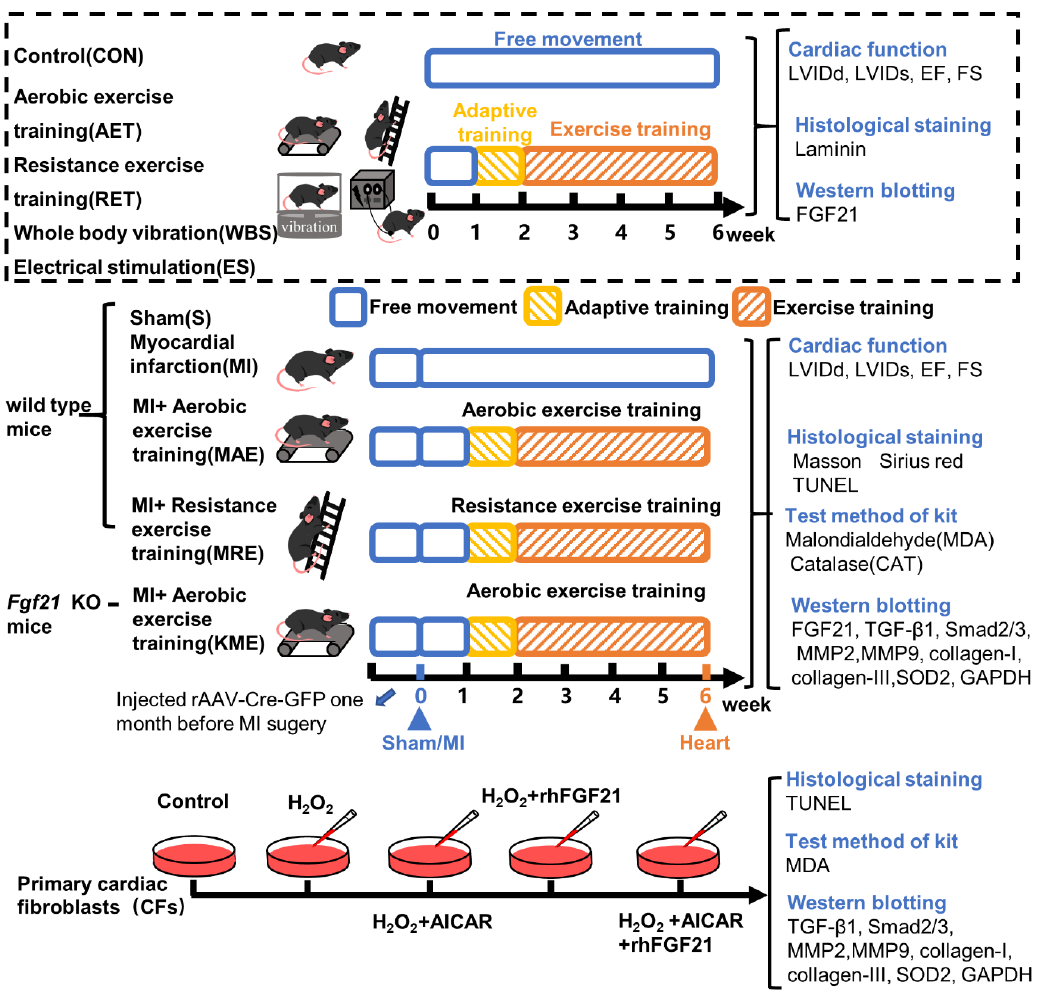
Figure 1. Schematic diagram of experimental design.